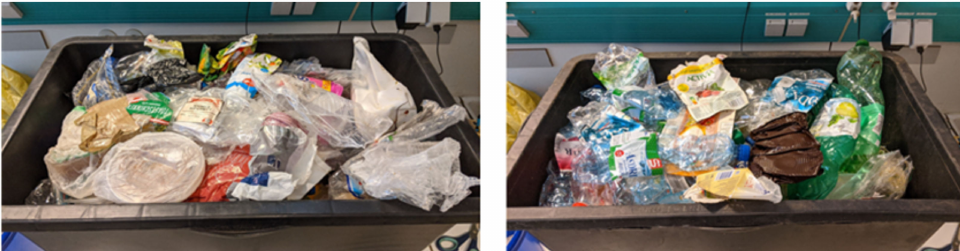
Figure 1. Exemplary manually pre-sorted bulky three-dimensional plastic packaging waste. Left : Two-dimensional flexible plastic waste. Right : Three-dimensional solid plastic